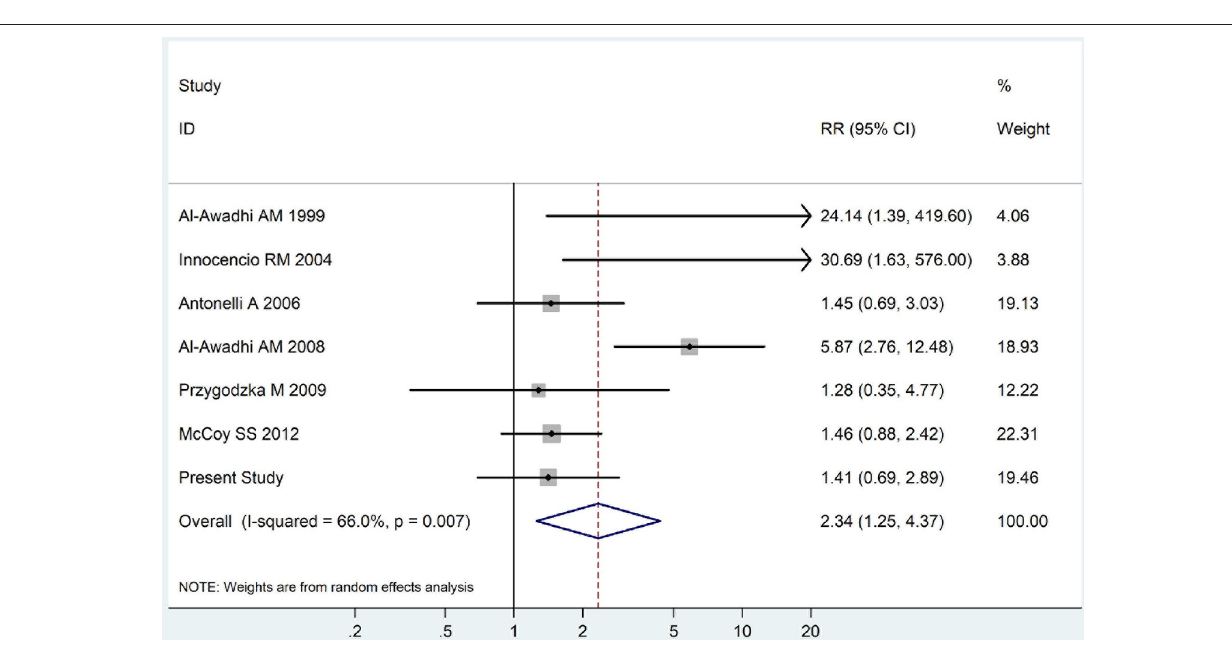
published in 2017, which demonstrated an obvious